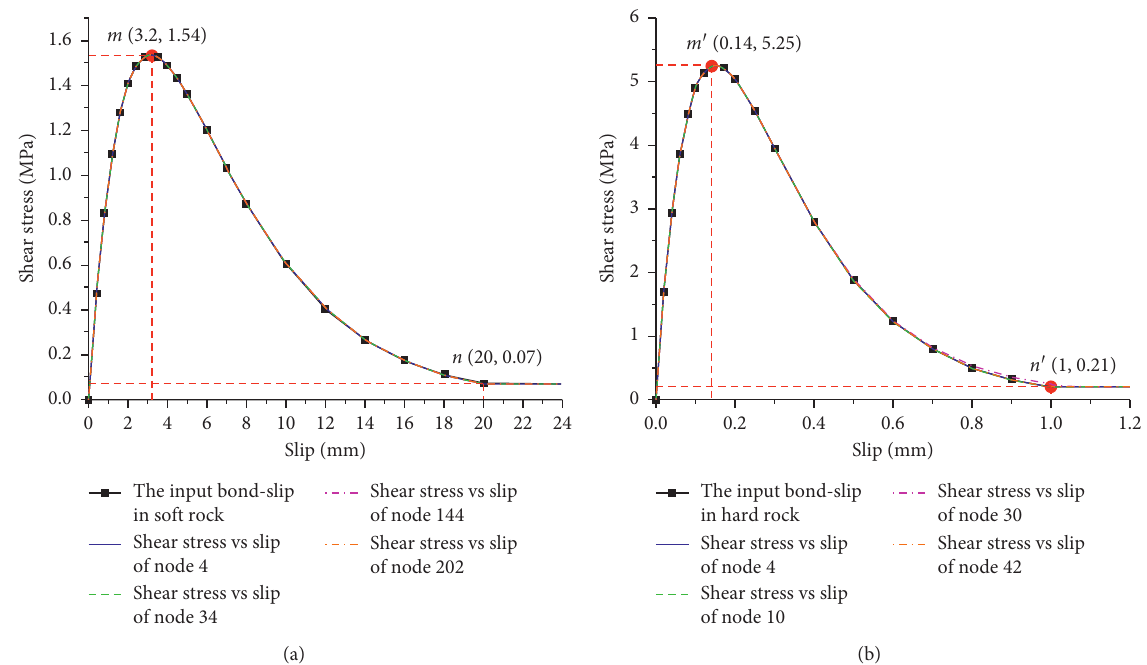
Figure 8: Comparison of bond-slip curves at different nodes with the input bond-slip relationship in (a) soft rock and (b) hard rock.